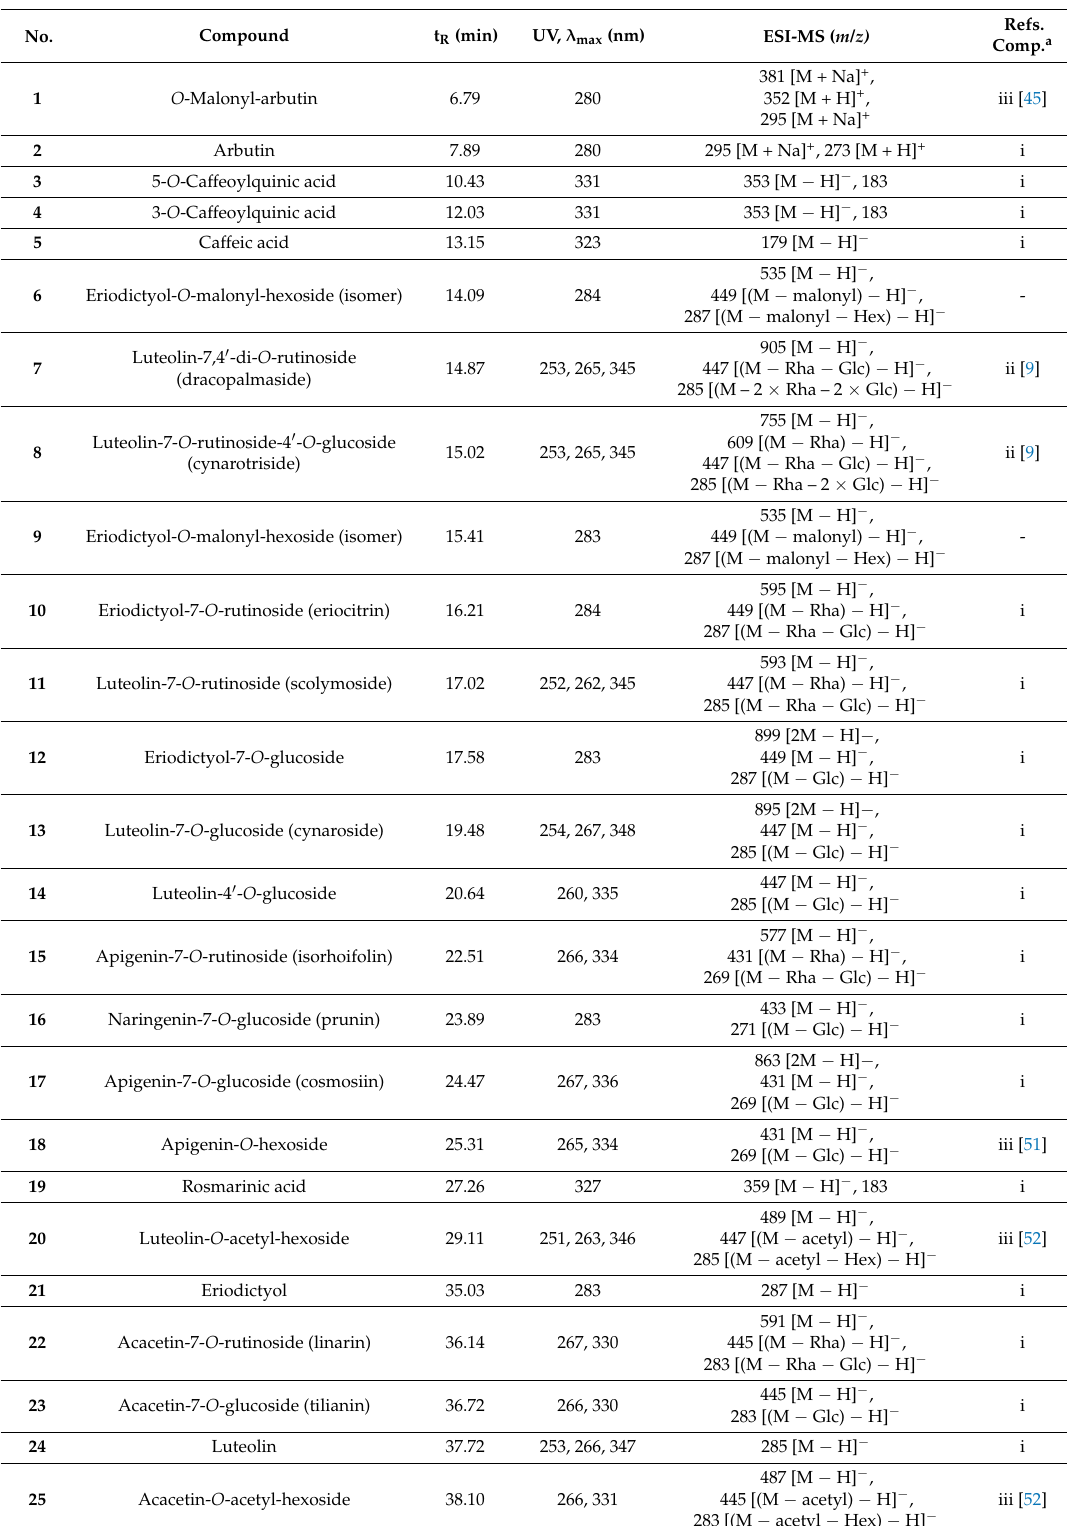
Table 4. HPLC parameters, ultraviolet spectra data (UV) and electrospray ionization mass spectrometry (ESI-MS) data of components 1 – 32 from D. palmatum